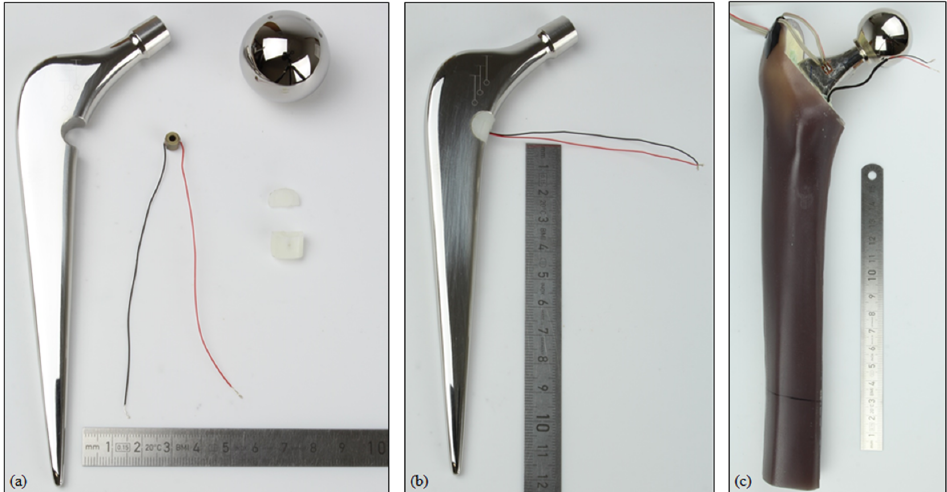
Figure 2. ( a ) Single parts of the modified total hip stem with the energy harvesting system (metallic implant component, prosthetic head, piezoelectric element, UHMW-PE housing in two pieces); ( b ) fully assembled system; ( c ) implanted system within the artificial bone segment, with the wires from the strain gauge and piezoelectric element visible.